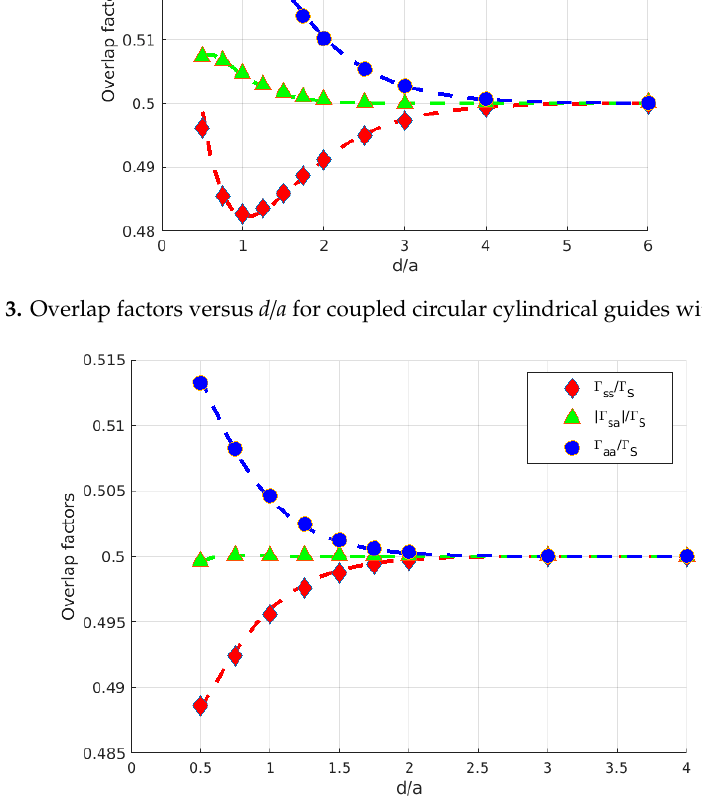
Figure 4. Overlap factors versus d / a for coupled circular cylindrical guides with v = 2.255.